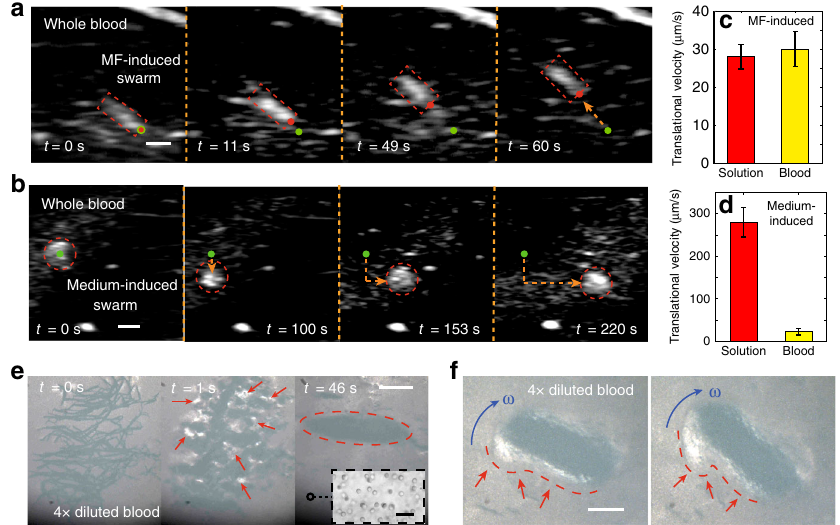
Fig. 6 The navigated locomotion of MF-induced and medium-induced swarms in whole blood. a The steered locomotion of an MF-induced swarm in whole blood. b The navigation of a medium-induced swarm in whole blood. In a , b the scale bars indicate 1 mm. c The comparison between the translational velocities of the MF-induced swarms in glycerol – water solution and in whole blood, with the same viscosity. The applied pitch angle is 10 (cid:7) . d The comparison between the translational velocities of the medium-induced swarms in glycerol – water solution and in whole blood, with a pitch angle of 6 (cid:7) . The error bars in c , d indicate the standard deviation obtained from three experiments. e The generation of an MF-induced swarm in 4 ´ diluted blood. The red dashed ellipse indicates the formed swarm. f The turning motion of an MF-induced swarm in 4 ´ diluted blood for the investigation of swarm-cell interaction. In e , f , the scale bars indicate 500 μ m. The scale bar in the inset of e represents 20 μ m. The error bars in c , d indicate standard deviations obtained from fi ve experiments.